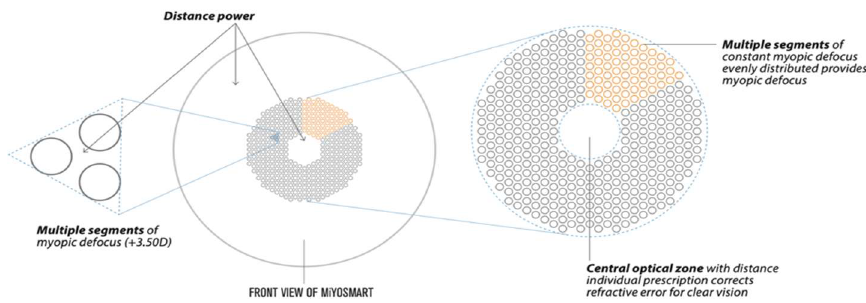
lens. Available online: www.hoyavision.com (accessed on 30 December Figure 1. The design of the Defocus Incorporated Multiple Segments (DIMS) MiYOSMART spectacle lens [Available online: www.hoyavision.com (accessed on 30 December 2021)] .